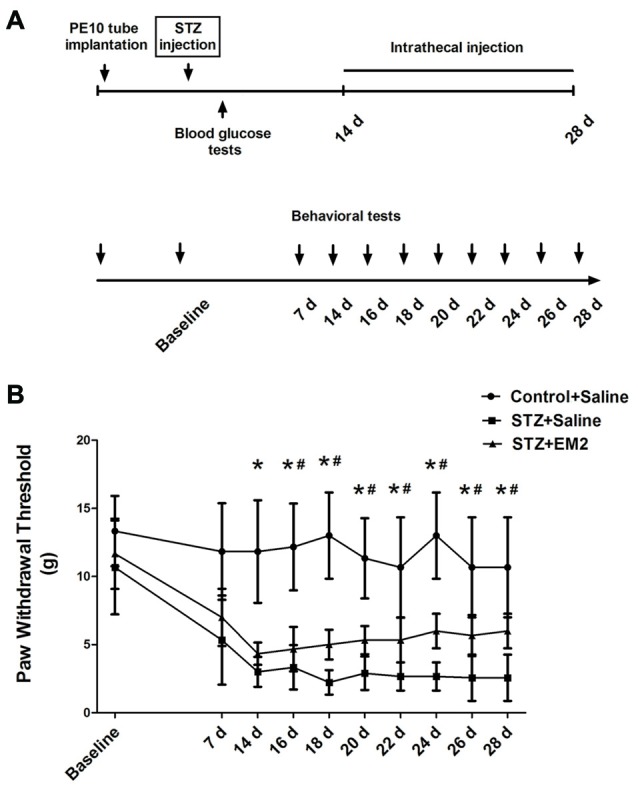
Effects of intrathecal EM2 on mechanical sensitivity in diabetic rats compared with the controls. PWTs were measured before (baseline), day 7, 14, 16, 18, 20, 22, 24, 26 and 28 (A). Intrathecal injection of EM2 from day 14 to day 28 alleviated the mechanical allodynia (B) in the diabetic rat. Mean ± SD, n = 6 per group, *p < 0.05 vs. STZ rats-saline group at corresponding time points, #p < 0.05 vs. control-saline group at corresponding time points.